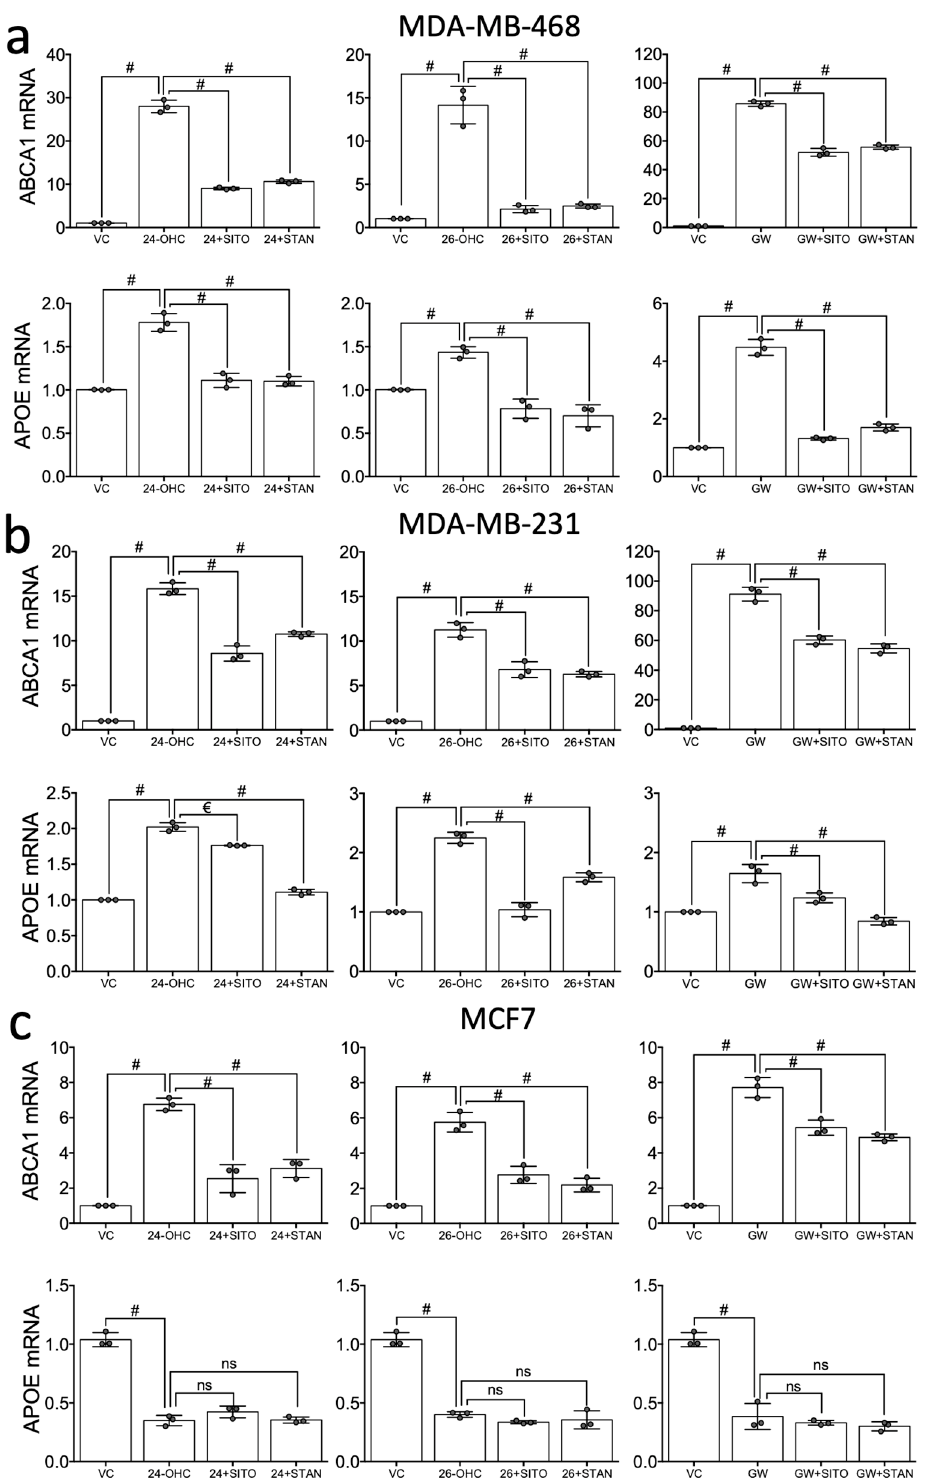
Figure 6. STAN and SITO suppress oxysterol mediated LXR expression of target genes. Hormone receptor negative (MDA-MB-468 ( a ) and MDA-MB-231 ( b )) and positive (MCF7 ( c )) cells were treated with LXR ligands (synthetic 1 µM, oxysterol 10 µM) for 16 hr alone or in combination with SITO or STAN and expression of ABCA1 and APOE were assessed by Taqman assays ( ∆∆ C t using HPRT and normalised to vehicle). Data shown are mean of three independent replicates (circles) with SEM. One-way ANOVA with Holm-Sidak correction for multiple testing was performed, significance is indicated by € = p < 0.05 and # = p < 0.0001.